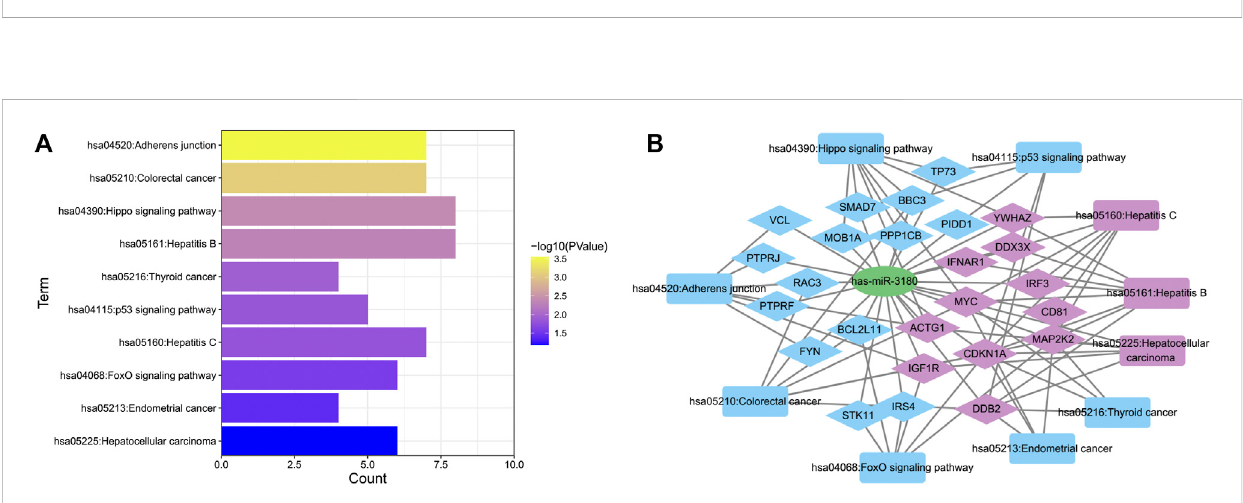
FIGURE 6 Biological functionoftargetgenes ofhsa-miRNA-3180. (A) Chart oftop10 enrichedpathwaysofthetarget genesofhsa-miRNA-3180. (B) Network of hsa-miRNA-3180 and its target genes and enriched pathways. Purple represents target genes and pathways related with hepatitis and liver carcinoma and blue represents target genes and pathways related with other